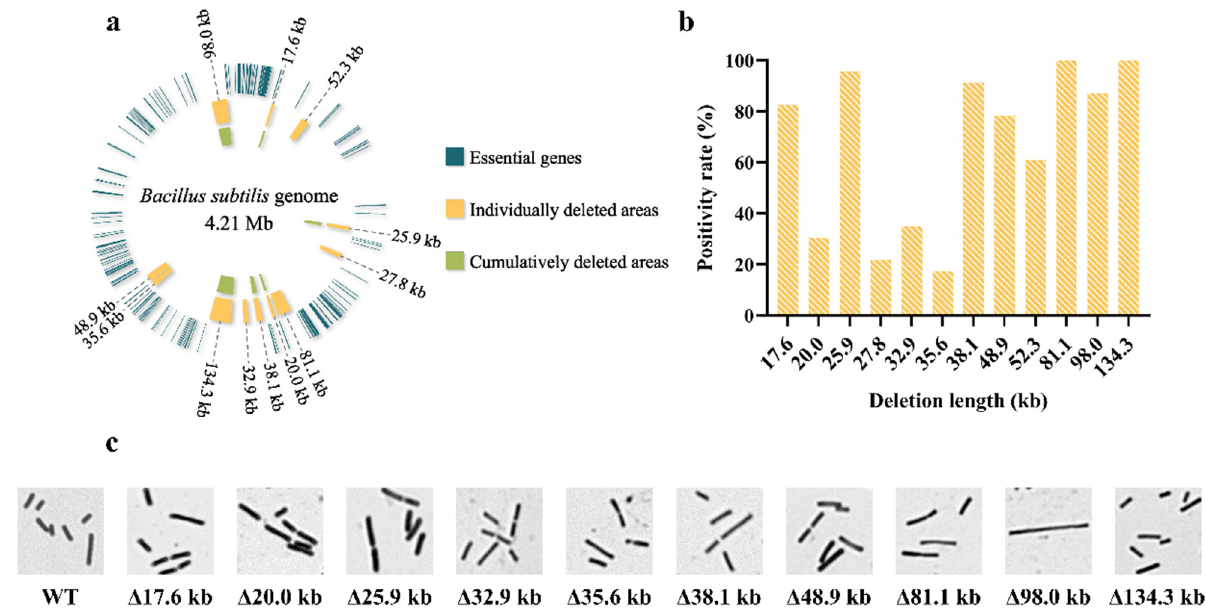
Figure 2. The genomic positions and positivity rates of long fragment deletions ( a ) Position of each deleted long fragment in the genome. ( b ) Positivity rate statistics of each long fragment deletion. ( c ) Morphological comparison of the wild-type strain (WT) and long fragment deletion strains. All strains were Gram-stained and observed using light microscopy.